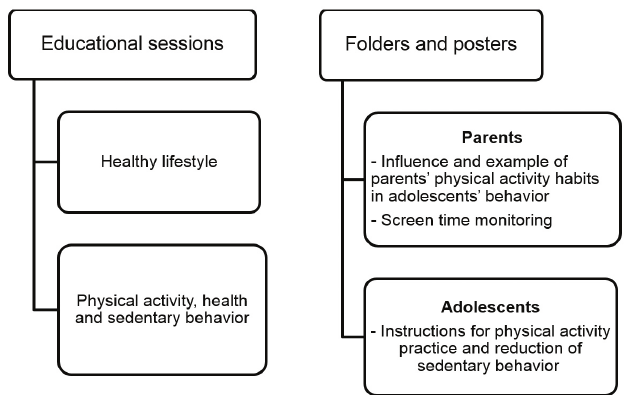
Figure 2. Organizational chart of actions applied in the “MEXA- SE” intervention specifically focused on screen time